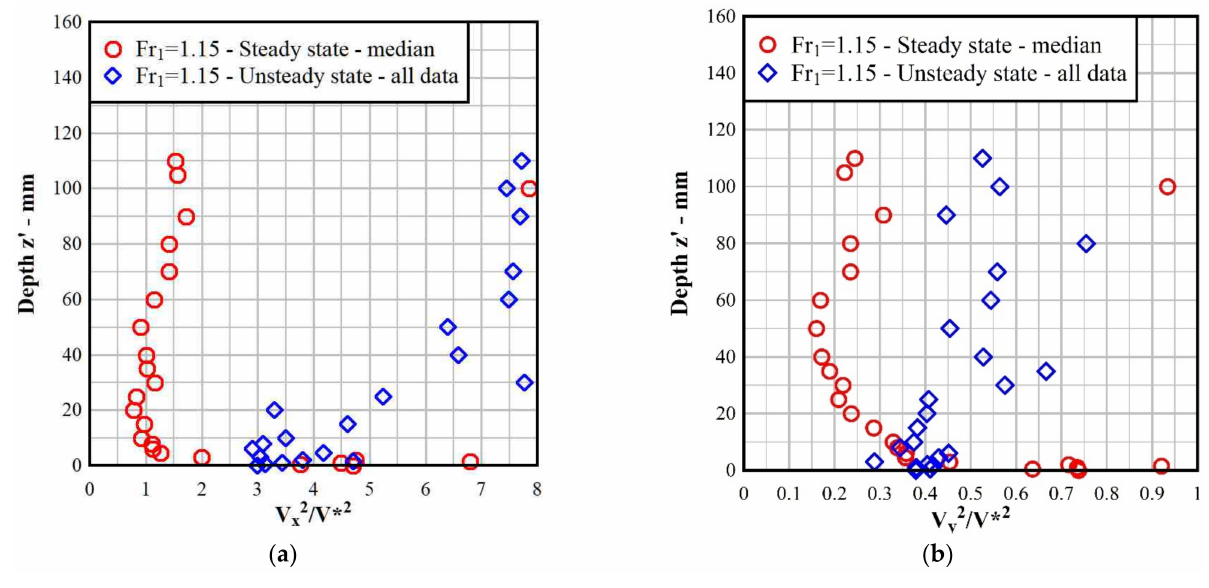
Figure 6. Undular surge, Run 60-7. Dimensionless normal Reynolds stresses ( a ) V x 2 / V * 2 ; ( b ) V y 2 / V * 2 .